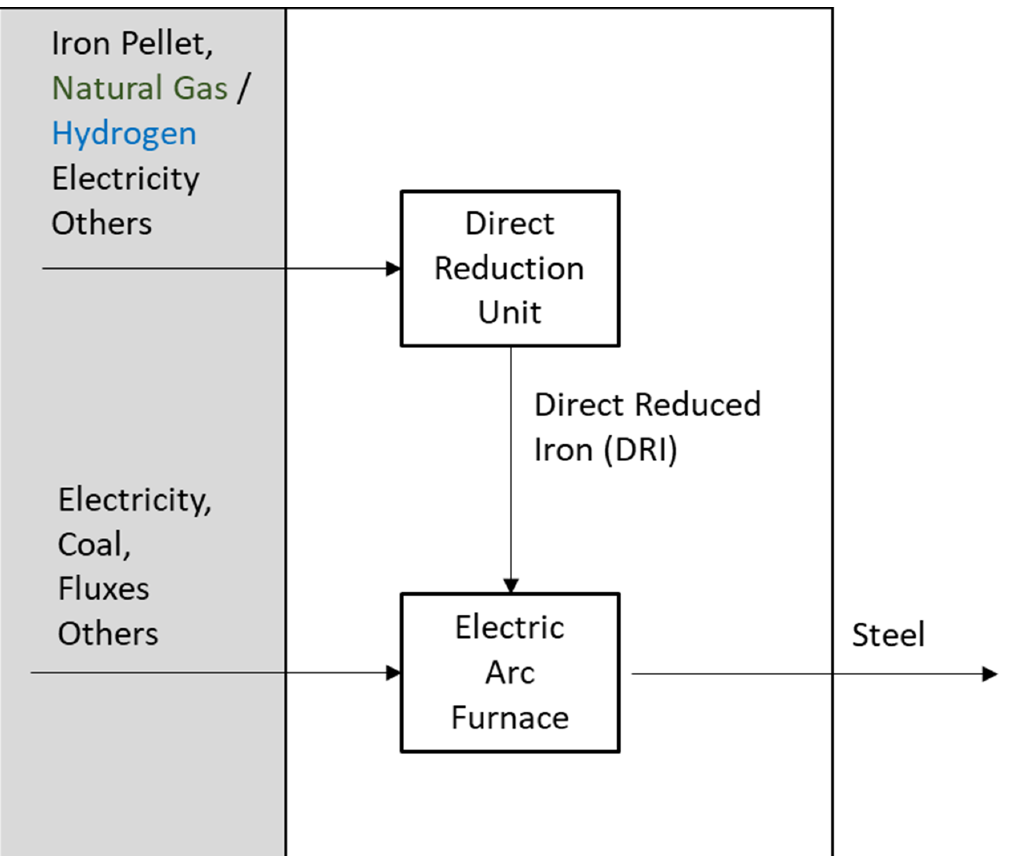
Figure 5. Steel production over the DR-EAF route. The steel manufacturing processes are listed in the white area and the inputs for these processes in the grey area. The environmental impacts of both are considered in this paper according to a cradle-to-gate approach. Either natural gas or hydrogen is used as reducing agent. Hydrogen is assumed to be obtained using electrolysis (see Figure 2).